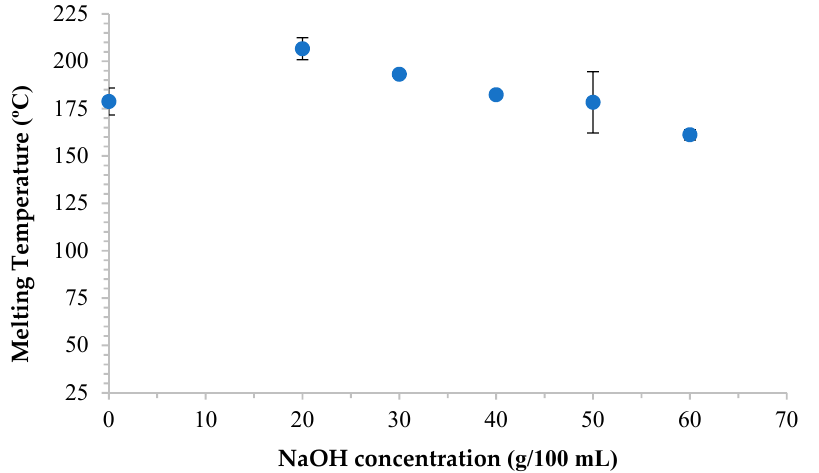
Figure 5. Thermal property of cellulose from asparagus stalk end and CMC as synthesized with various NaOH concentrations.